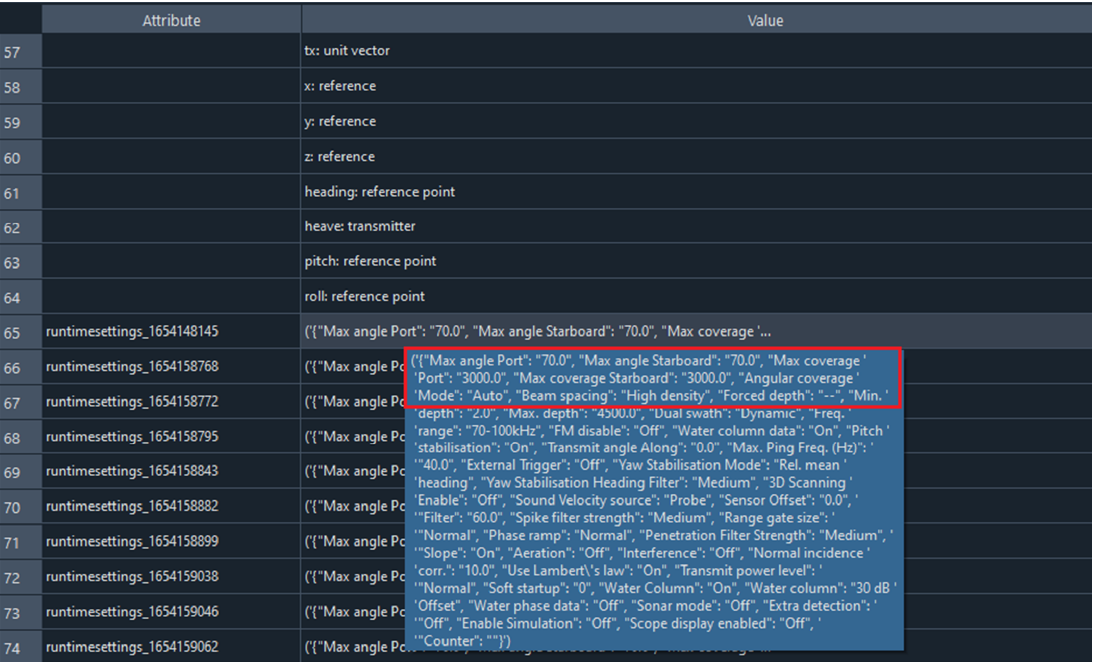
Figure 11. Runtime parameters as shown in the Kluster Attribute window. Illustrates the runtime parameters for the second extinction test, where the Angular Coverage was changed to Auto.